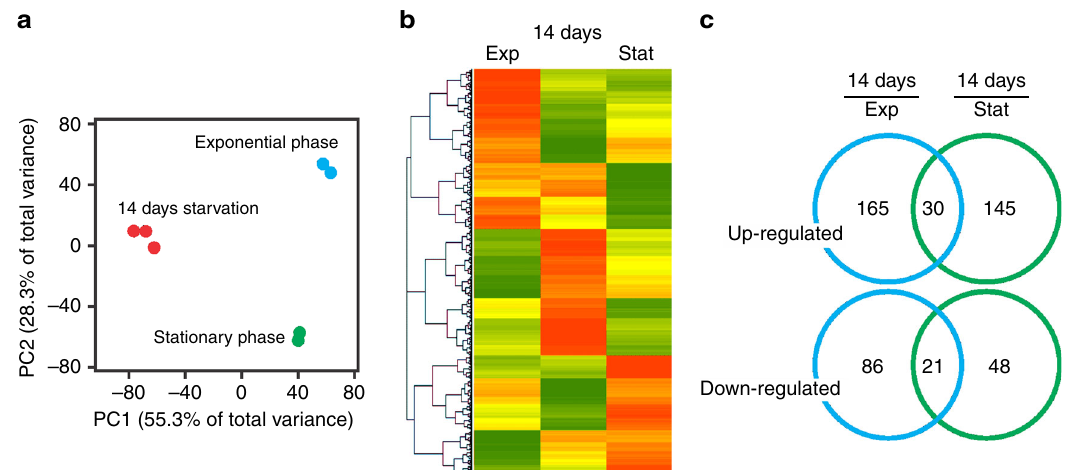
Fig. 5 Transcriptome comparison. Transcriptomes (RNA-seq) of B. subtilis Δ spoIIE were analyzed for cells incubated 14 days in starvation buffer (in triplicate), and for cells grown in Spizizen minimal medium (SMM) and harvested in exponential or stationary growth phase, respectively (each in duplicate). a Principal component analysis plot of the different samples. Samples were plotted against the fi rst two principal components calculated from the gene expression values. The axes labels indicate percentage of total variance that is explained by each component. b Heat map of the averaged transcriptome pro fi les. Expression levels were transformed to Z -scores. Green indicates low expression ( Z -score = − 3.5), yellow indicates average expression ( Z -score = 0), and red indicates high expression ( Z -score = + 3). c Venn diagram indicating the number of upregulated and downregulated genes in 14-day-starved cells compared to exponential growth phase cells (left) and stationary growth phase cells (right). Strain used: B. subtilis PG344